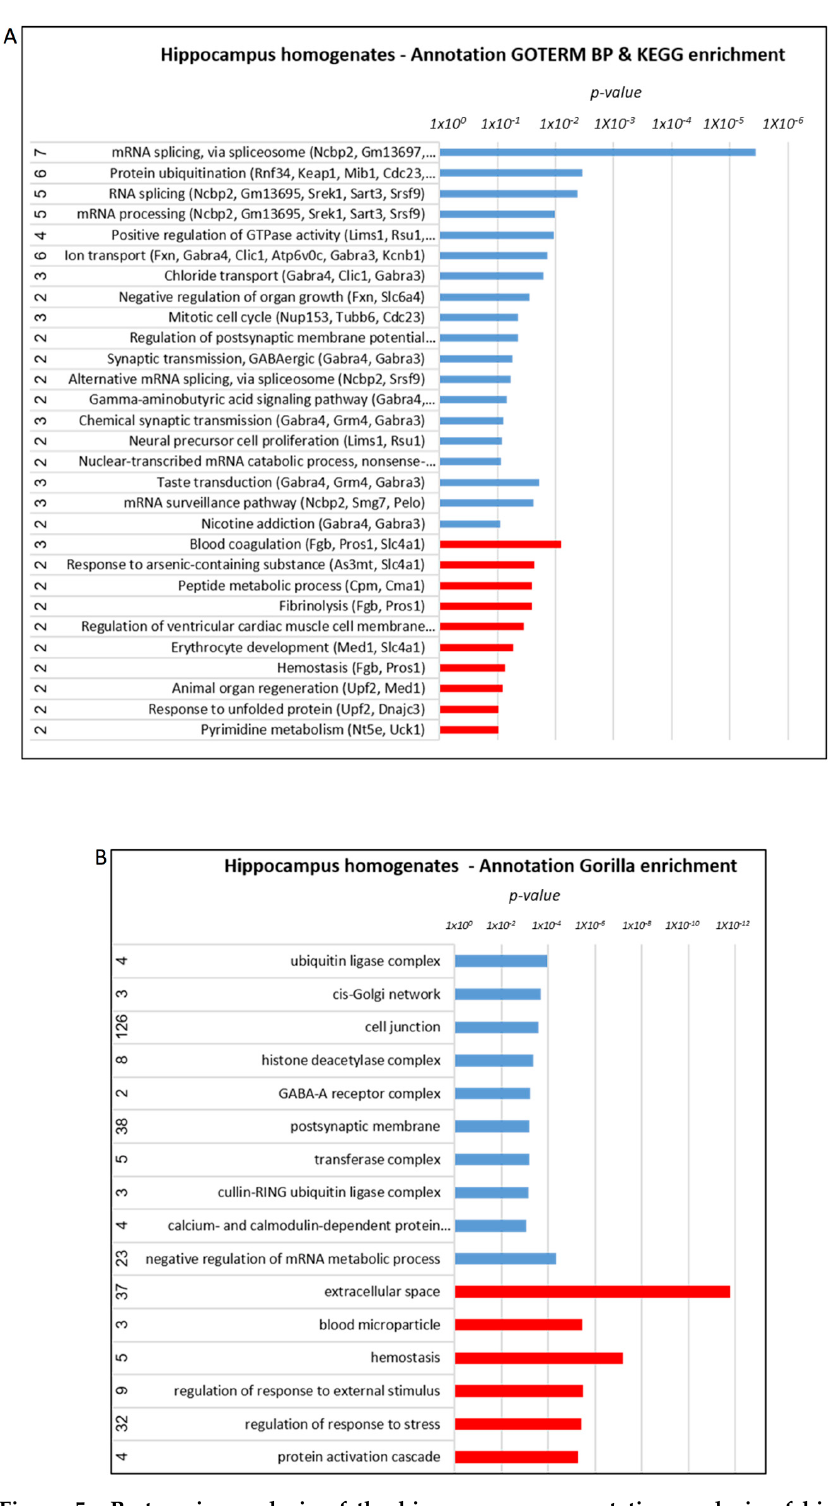
Figure 5. Proteomics analysis of the hippocampus: annotation analysis of hippocampus homogenates. ( A ) KEGG/GOTERM (names of affected proteins presented in brackets; full names of proteins are presented in Table S1 and Supplemental-hippocampus-proteomics-excel). ( B ) Gorilla enrichment. AD > treated AD—marked in blue, AD < treated AD—marked in red.